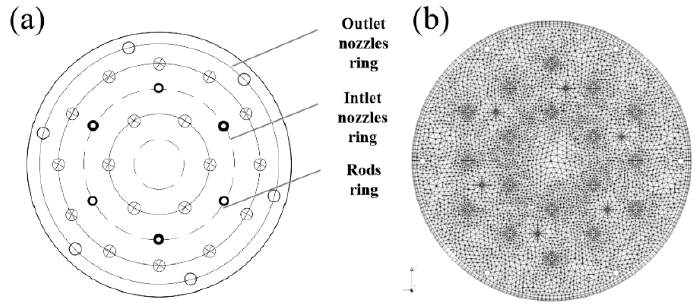
Figure 3. Diagram of base plate: ( a ) structure; ( b ) after meshing.